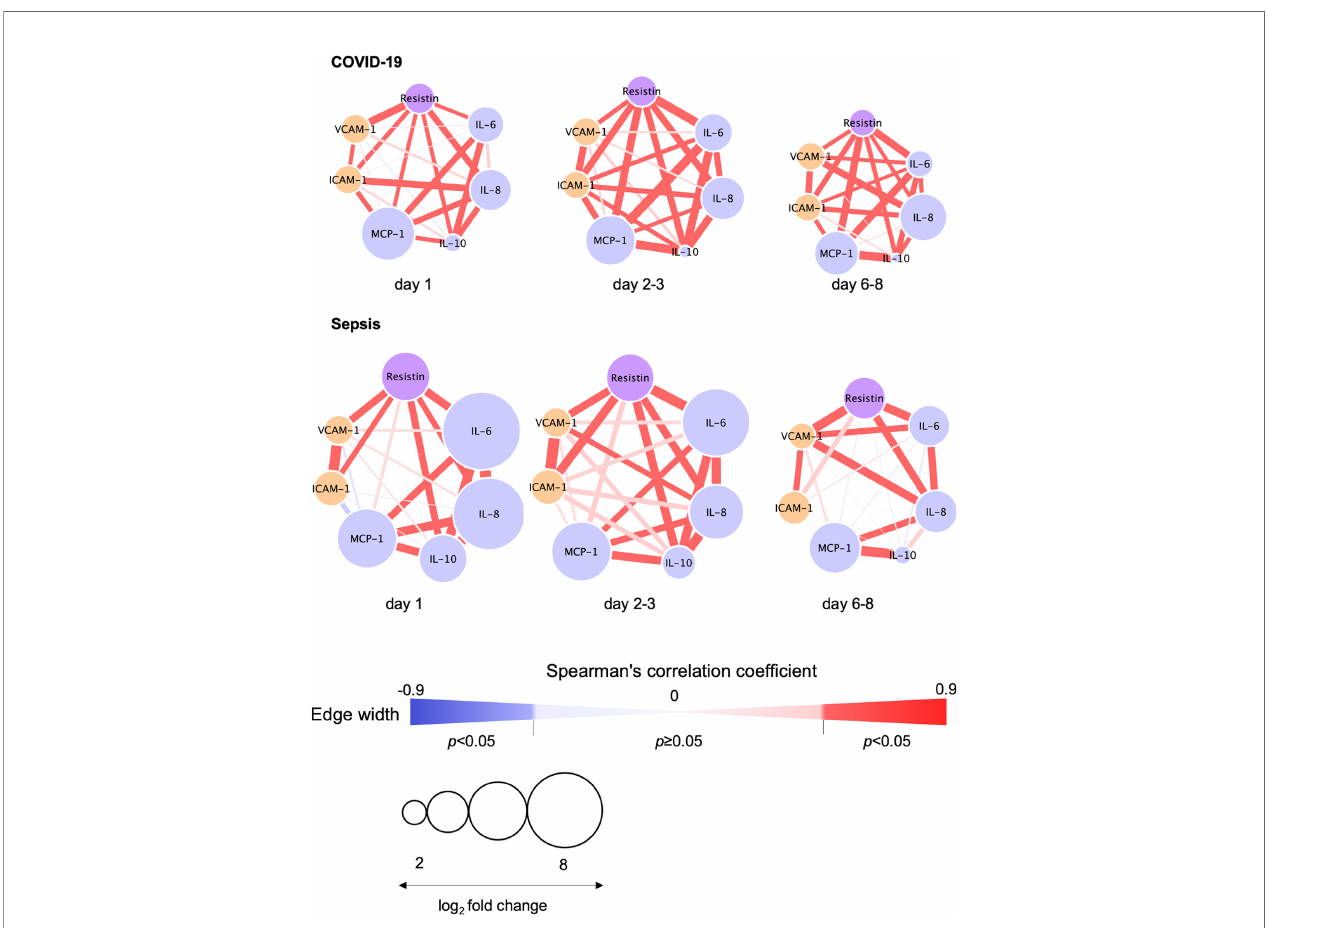
FIGURE 4 | Correlation visualization of resistin, 4 cytokines and 2 endothelial cell adhesion molecules. Resistin, cytokines and endothelial cell adhesion molecules were transformed to common logarithmic values to normalize the data distribution. The width of each edge indicates the Spearman ’ s correlation coef fi cients among resistin, cytokines and endothelial cell adhesion molecules. The red edge indicates a statistically signi fi cant correlation. The size of each node was determined based on the log2 fold change (i.e., average resistin, cytokine or endothelial damage marker levels in COVID-19 or sepsis patients/average resistin, cytokines or endothelial damage marker levels in controls). Node colors depict resistin (purple), cytokines (light blue) and endothelial damage markers (orange). COVID-19, coronavirus disease 2019; ICAM-1, intercellular adhesion molecule 1; IL, interleukin; MCP, monocyte chemotactic protein; VCAM-1, vascular cell adhesion